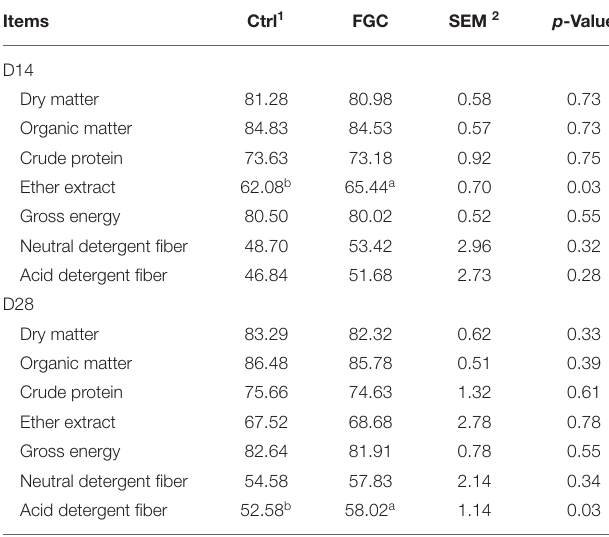
TABLE 2 | ATTD of piglets as affected by dietary FGC supplementation,